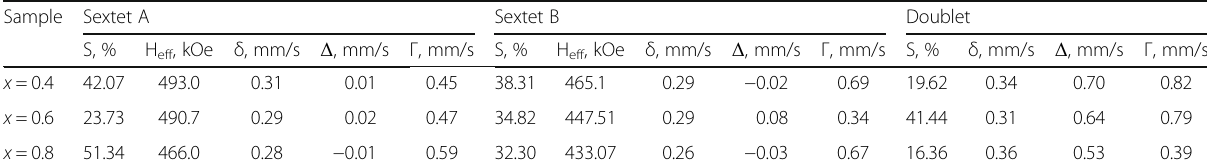
Table 4 Parameters of Mossbauer spectra Sample Sextet